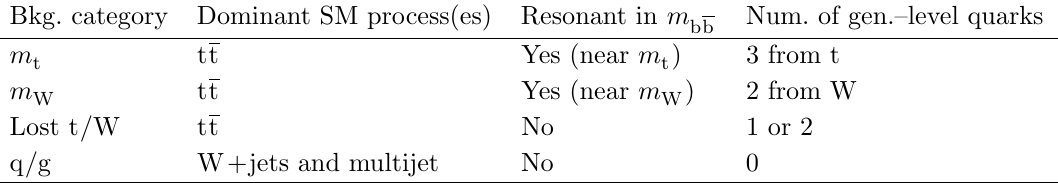
Table 2 . The four exclusive background categories with their kinematical properties and de(cid:12)ning number of generator-level quarks within (cid:1) R < 0 : 8 of the bb jet